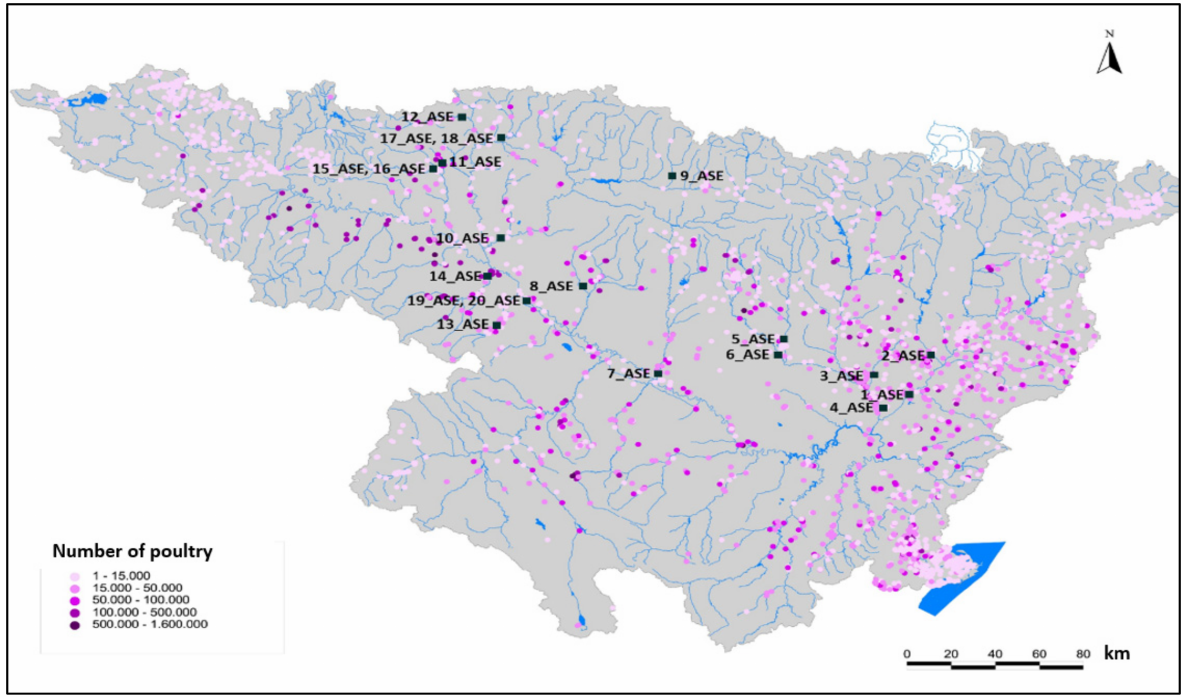
Figure 3. Distribution of number of poultry per farm in the Ebro River basin and sampling points (Source: Ebro Hydrographic Confederation,